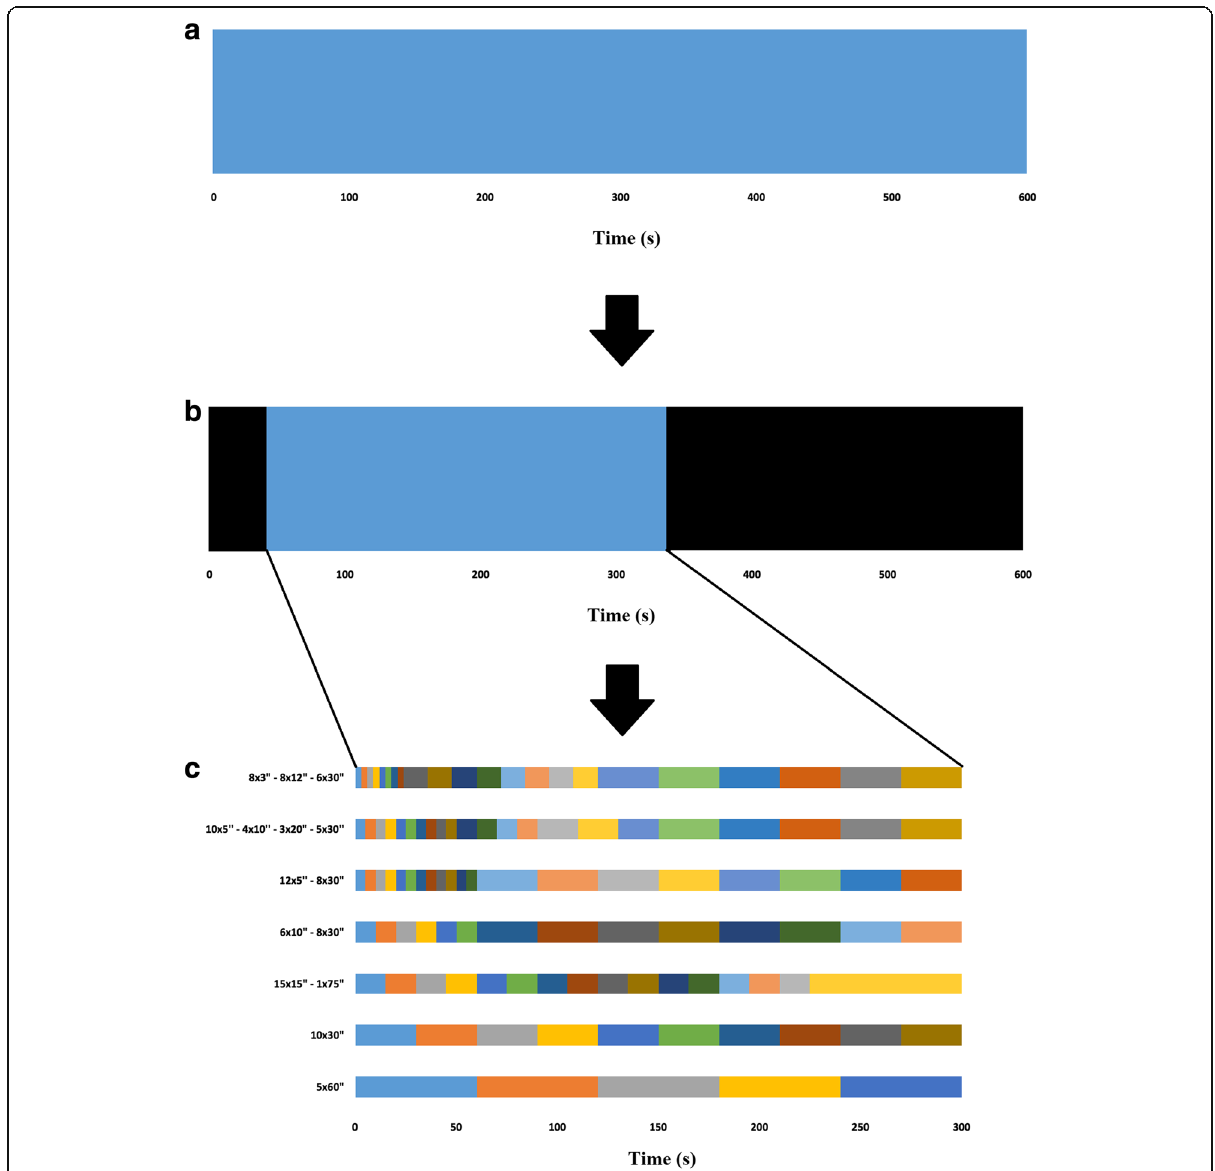
Fig. 1 Among the 600 s of the PET acquisition ( a ), the first seconds without any count were excluded and only 5 min from the arrival time of the FCH bolus were selected for each patient ( b ). Then, PET data were reconstructed into the seven different time samplings for each patient ( c